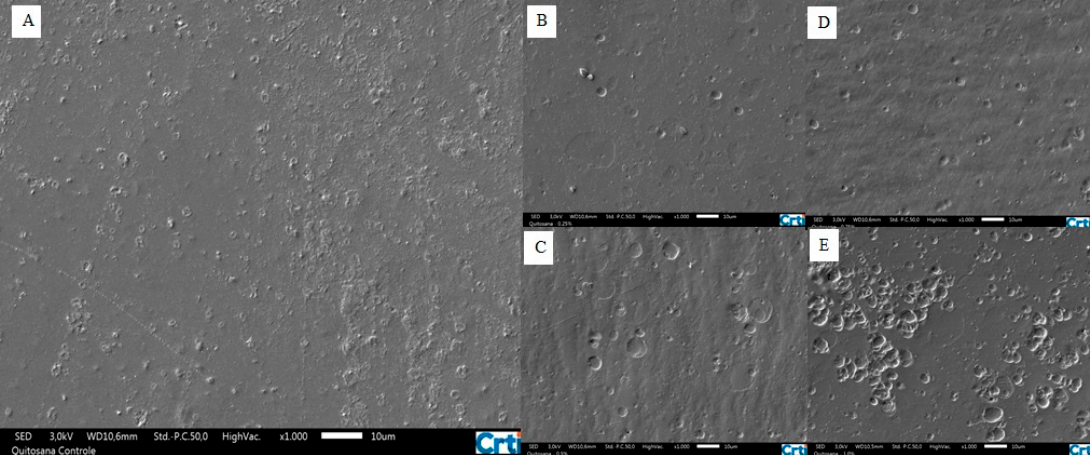
Figure 2. Micrographics (magnification 1000×) of chitosan films ( A ) with 0.25% ( B ), 0.50% ( C ), 0.75% ( D ) and 1.0% ( E ) of Citrus limonia essential oil.